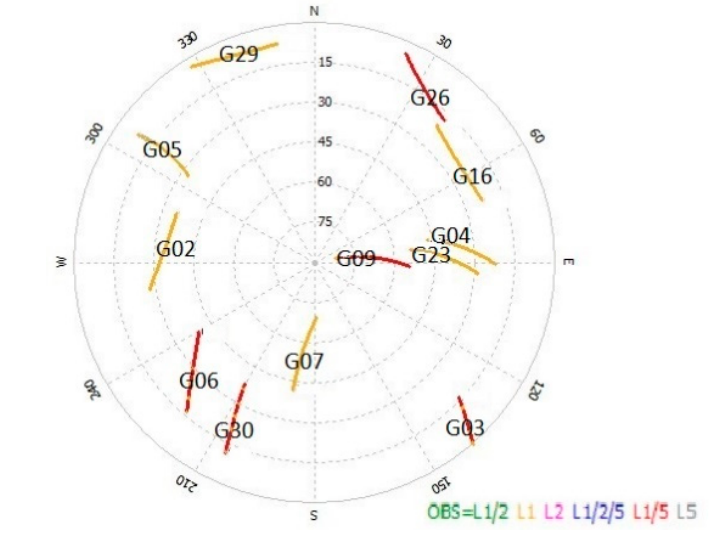
Figure 16. Huawei P30 Pro skyplot of Global Positioning System (GPS)-only.